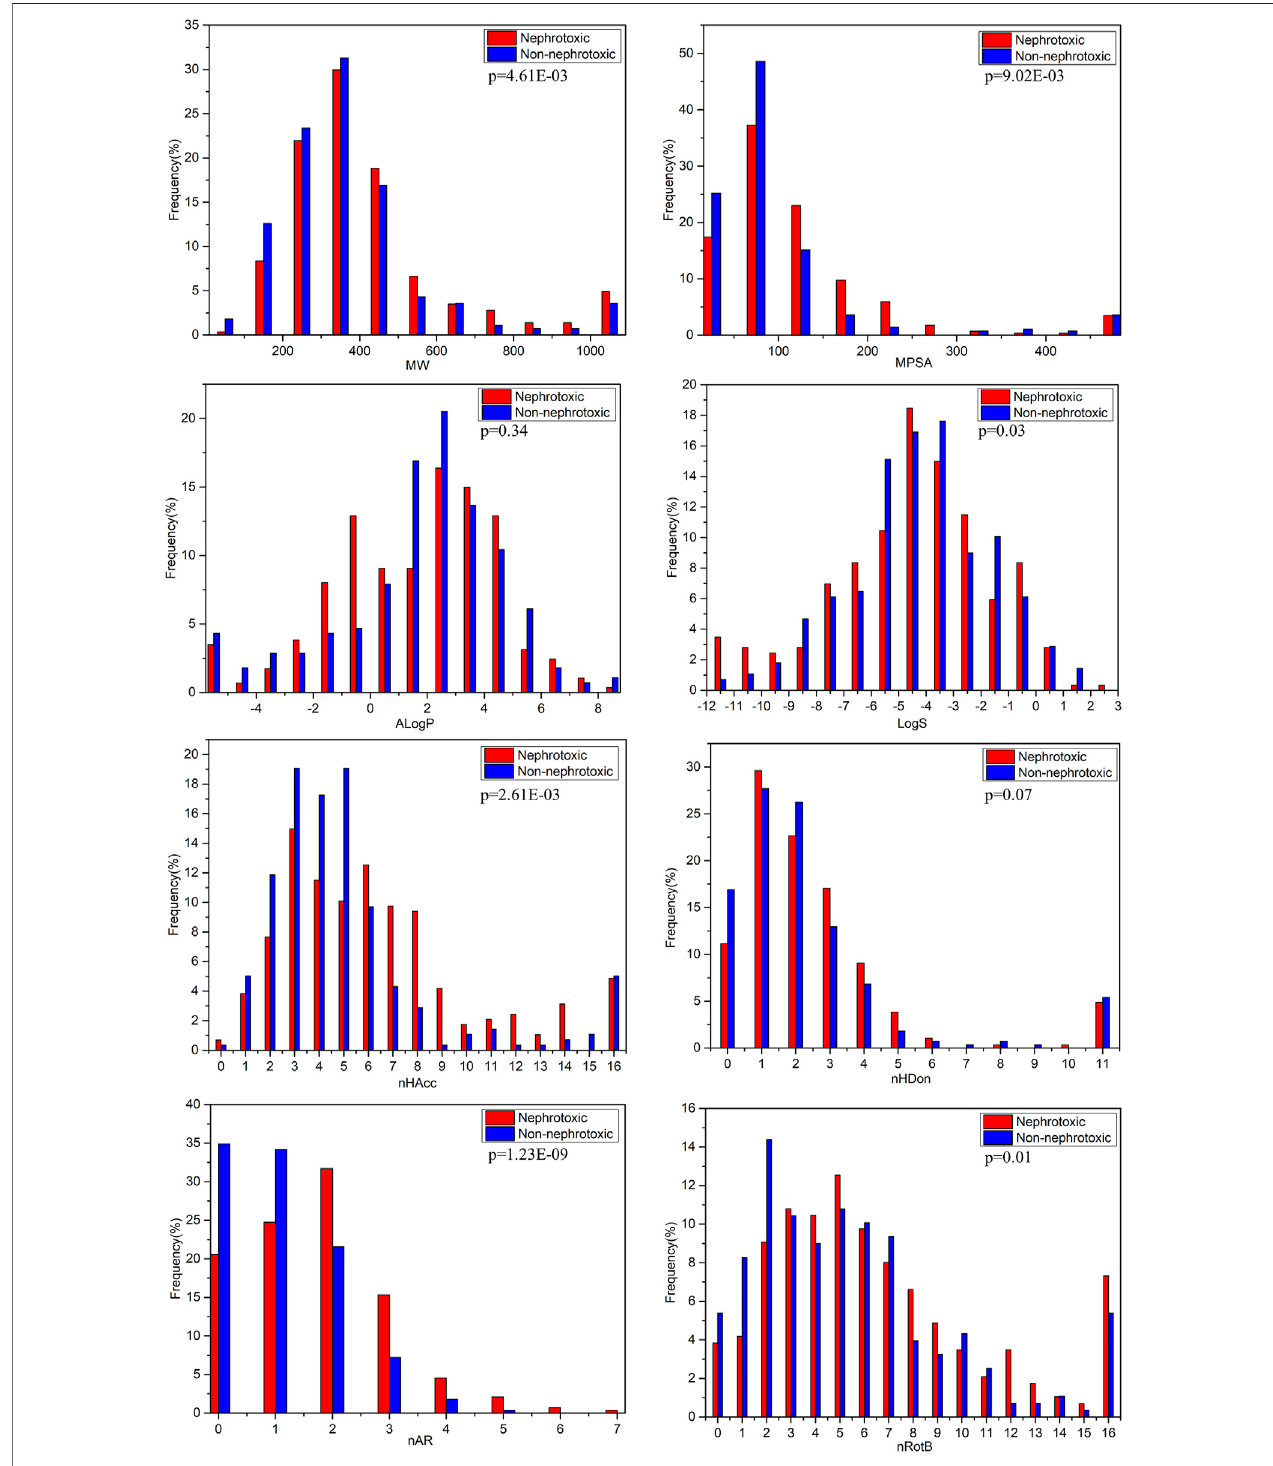
FIGURE 3 | Distributions of the commonly molecular properties for nephrotoxic and non-nephrotoxic drugs.